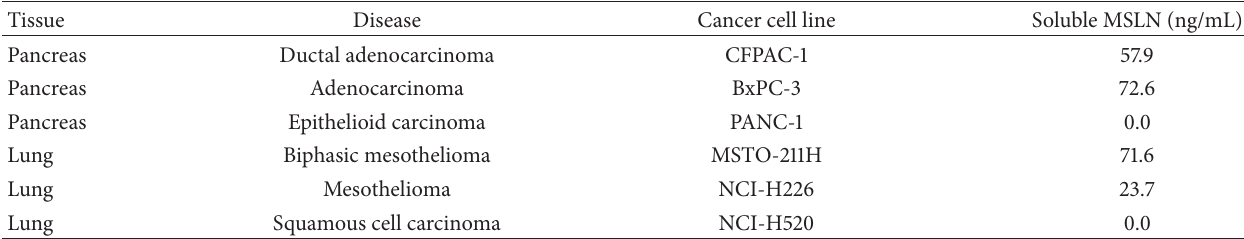
Table 1: Concentration of soluble MSLN in the culture media of cancer